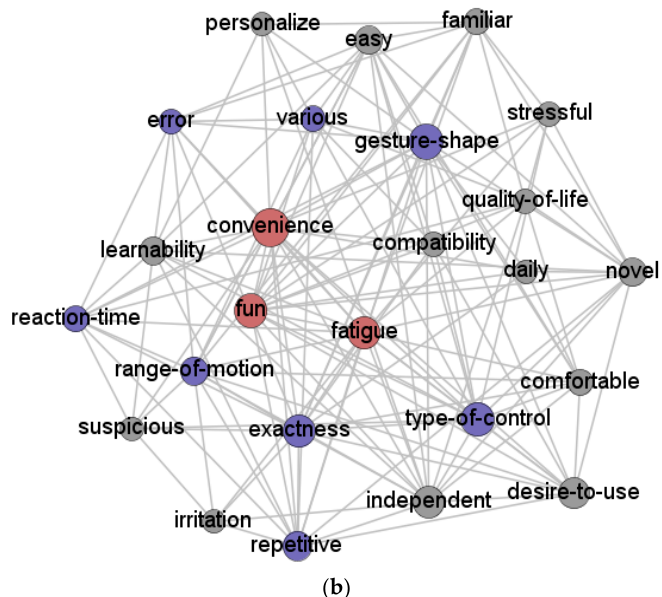
Figure 3. Semantic networks of smart TV gesture interactions. ( a ) Co-occurrence network of the 132 significant keywords. ( b ) Semantic network of representative nodes (red and blue nodes indicate core values and design variables, respectively).